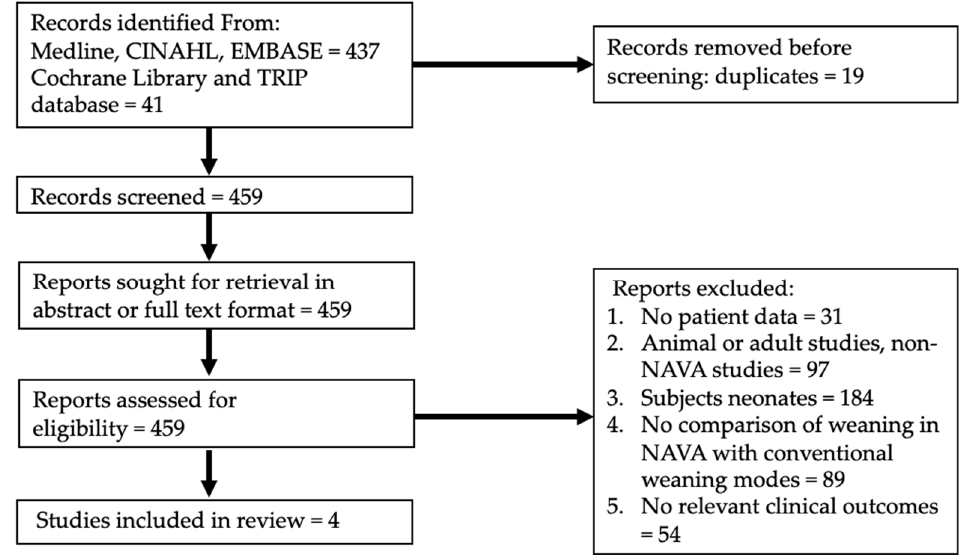
Figure 1. Flow diagram for systematic review of NAVA versus conventional weaning modes in children.